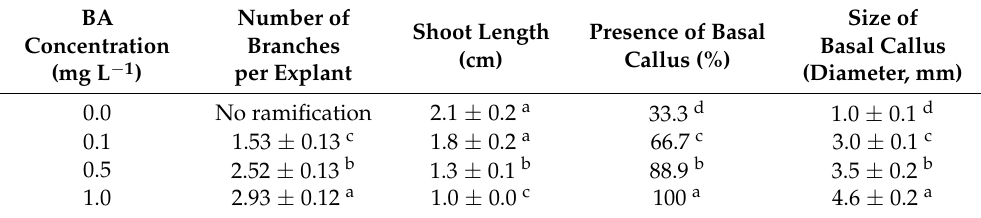
Table 1. Effect of different concentrations of benzyl adenine (BA) on carob shoot multiplication after 6 weeks. Each value represents the mean ± SE. Different letters in the same column indicate significant difference in mean values (Tukey’s HSD test) at p ≤